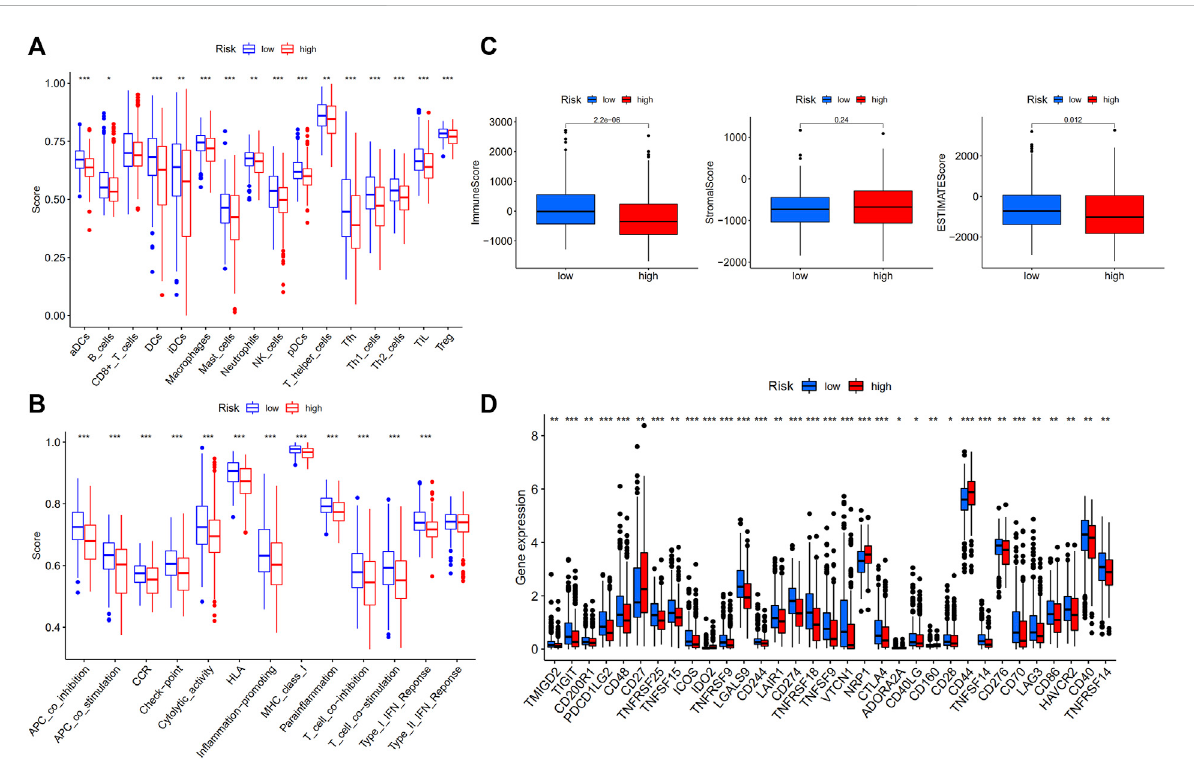
FIGURE 6 Comparison of ssGSEA scores in high- and low-risk groups inTCGA-THCAdatabase ( N = 498). (A) 16 immunecells and (B) 13 immune-related functions between high- and low-risk groups; (C) The ESTIMATE scores of high- and low-risk groups; (D) Comparison of immune checkpoint expression between high- and low-risk